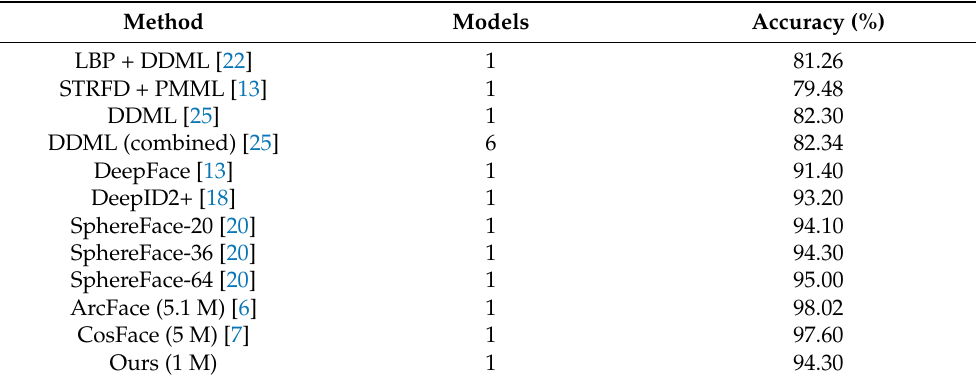
Table 3. Comparison of our method and other methods on the YTF.